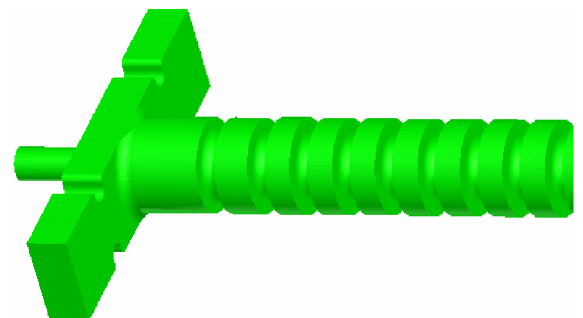
FIG. 4. (Color) Model of the TM mode launcher incorporated 01 as the coupler in an accelerator structure. The first cell matches the circular waveguide to the disk-loaded